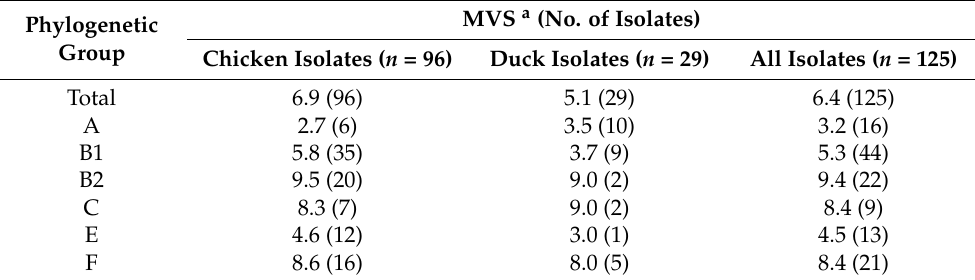
Table 3. Correlation between virulence-associated genes and phylogenetic groups among APEC isolates from chickens and ducks according to mean virulence score